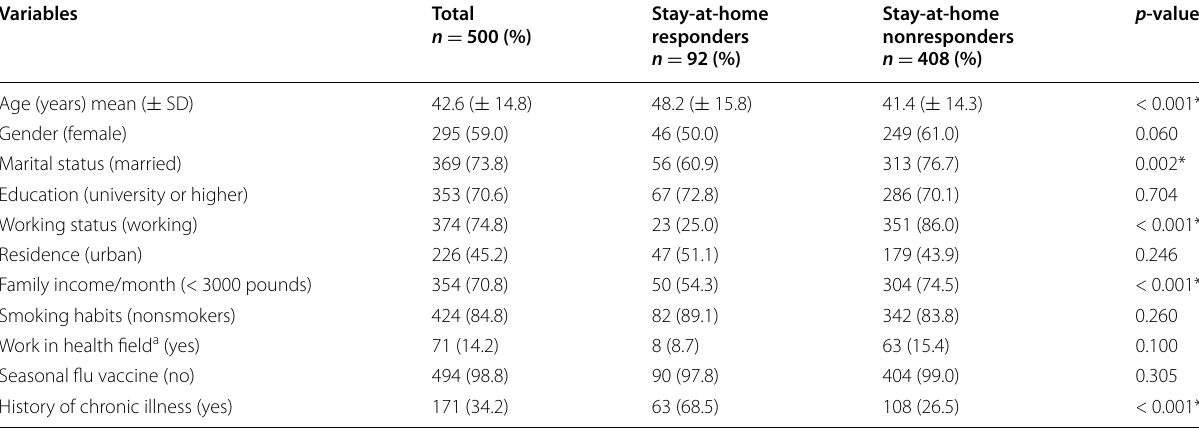
Table 1 General characteristics of studied population in Damietta Governorate, Egypt, during COVID-19 pandemic (April 10 to July 15,